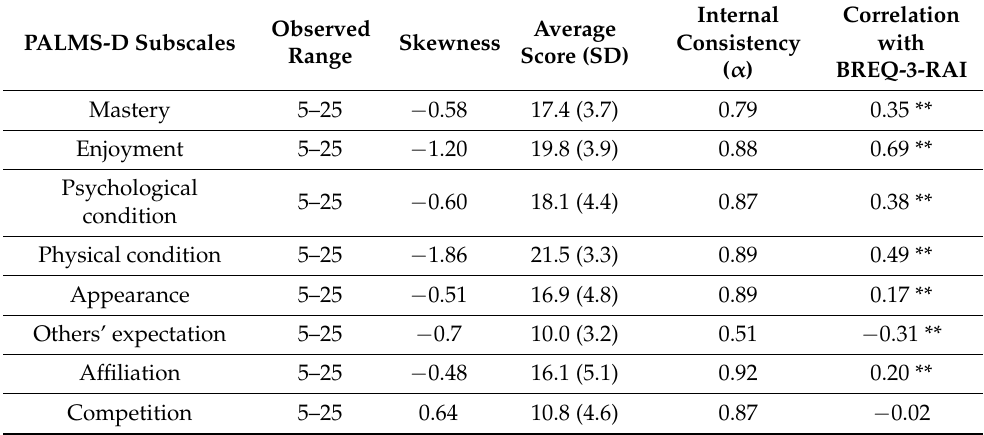
Table 4. Summary statistics of the PALMS-D subscales (N = 733); and correlation with the BREQ-RAI.